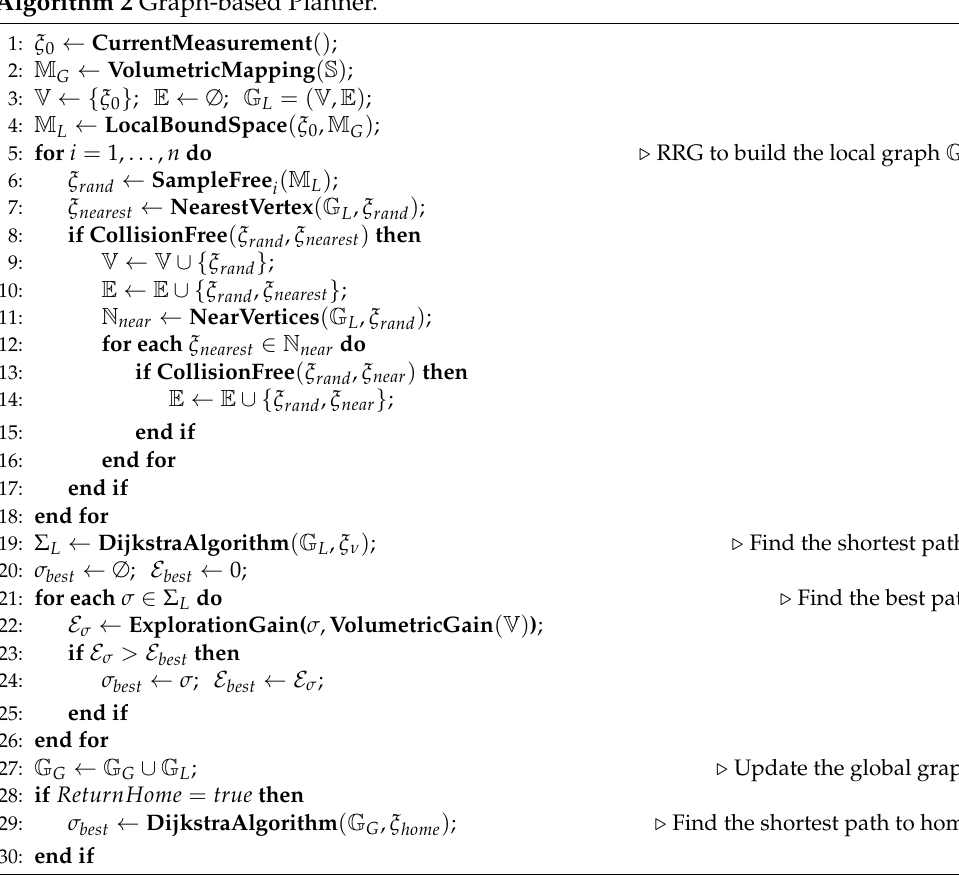
Algorithm 2 Graph-based